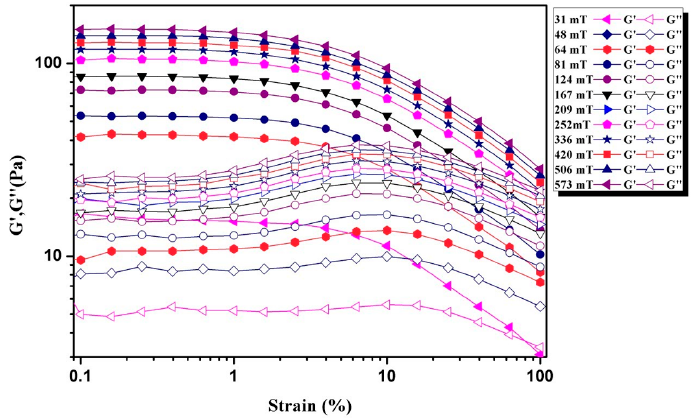
Figure 10. The variation in storage and loss moduli with respect to strain amplitude at an angular frequency of 10 rad/s.